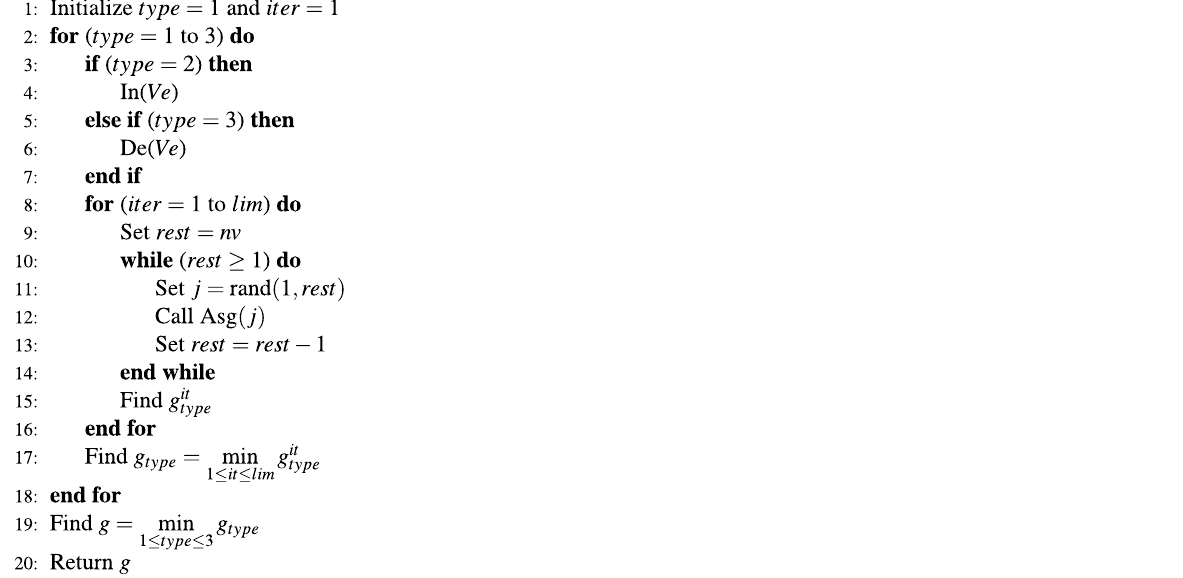
Table 2. Iterative random vehicle algorithm